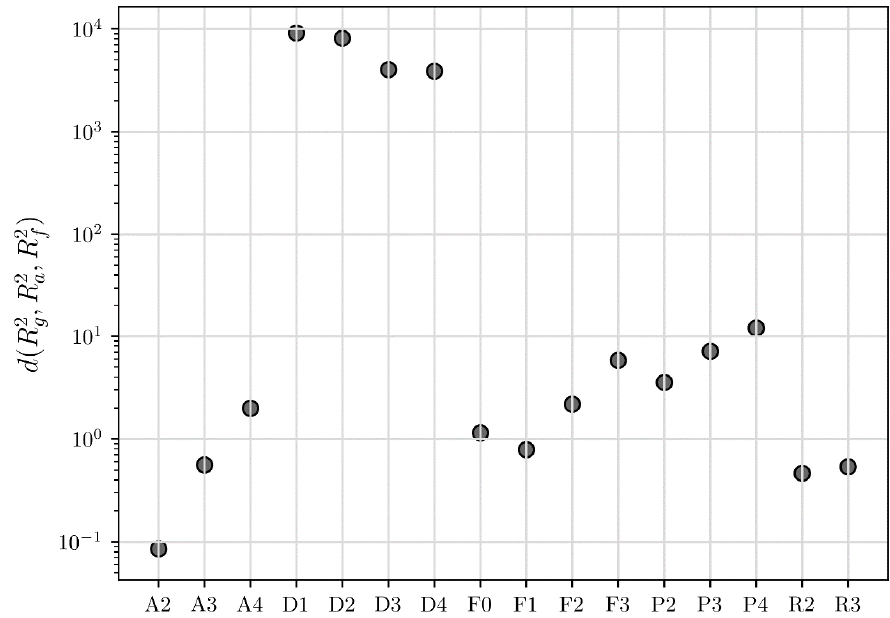
Figure 4. The calculated Euclidean distances via the COMF method for all the models presented in Table 1 in the case of the desolvation of the sulfameter solvate at 47.19 °C.